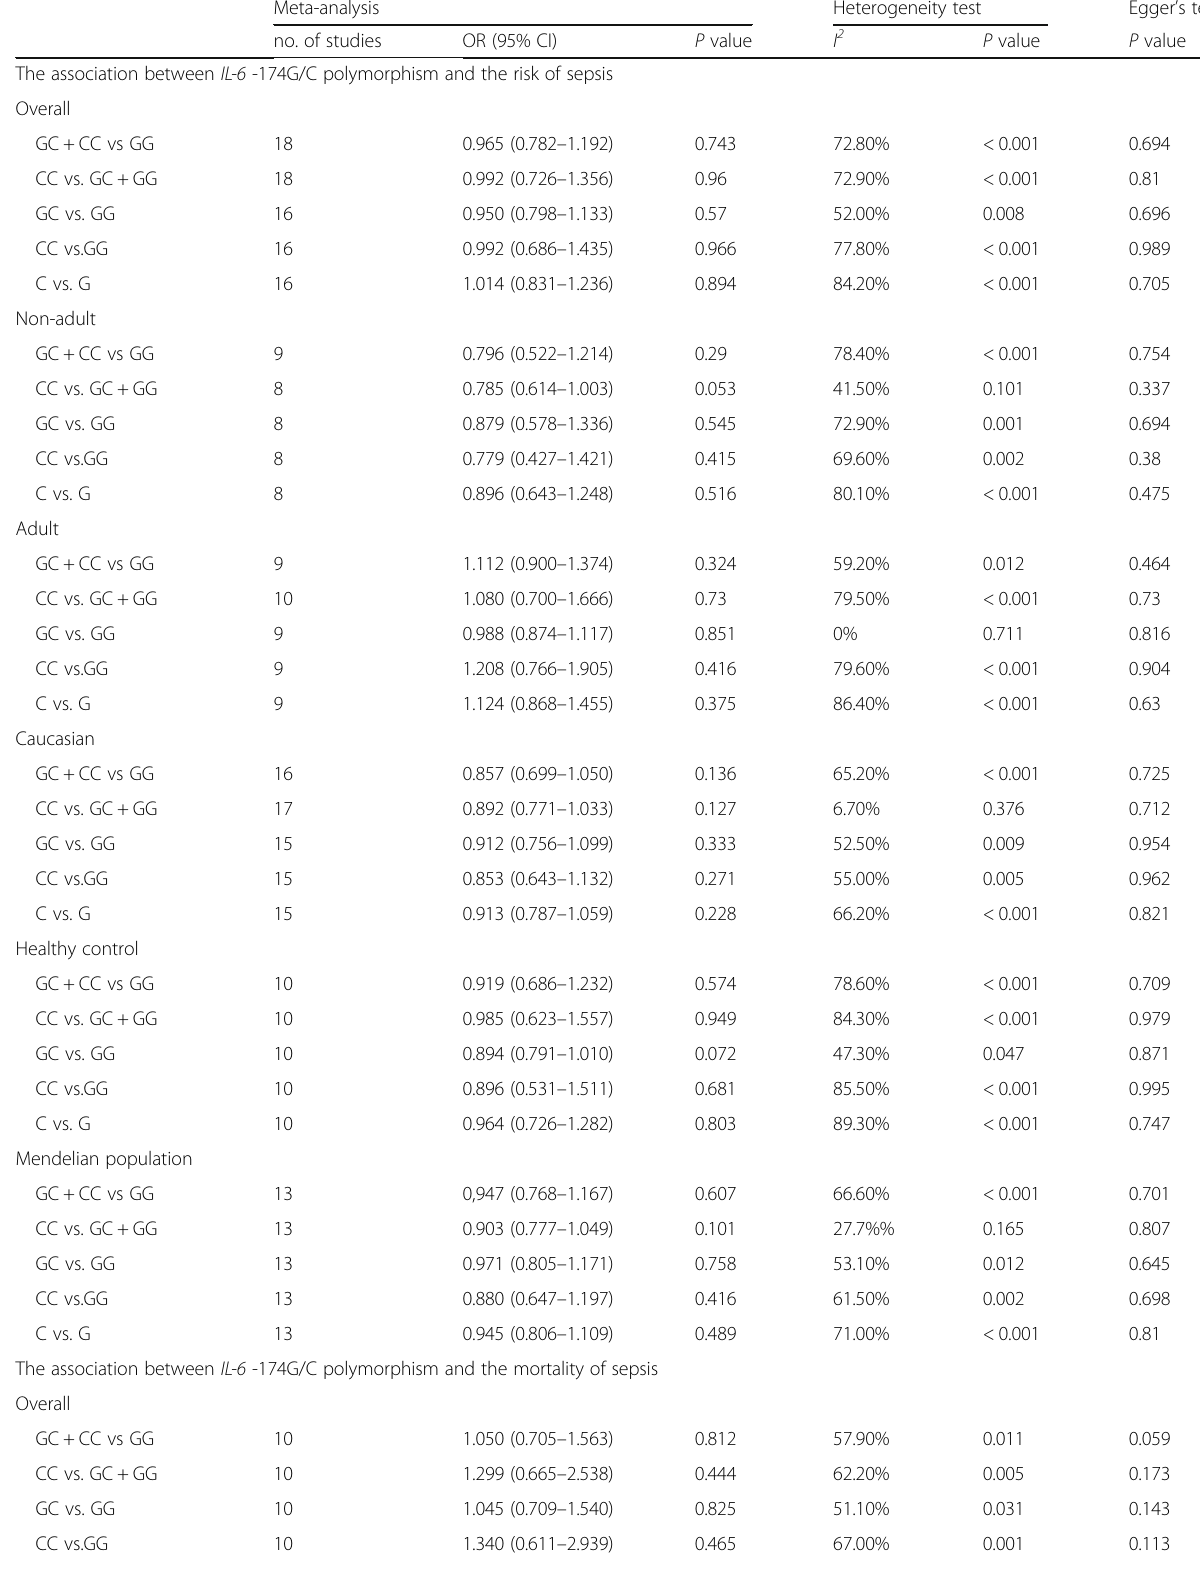
Table 2 Results of the meta-analysis, heterogeneity test and Egger ’ s